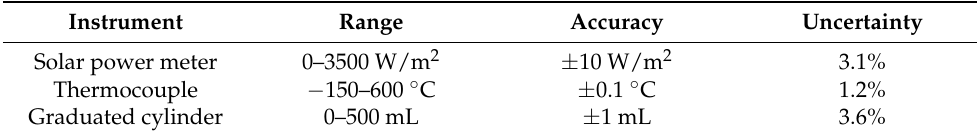
Table 4. Uncertainty, range, and accuracy of the measuring instruments.